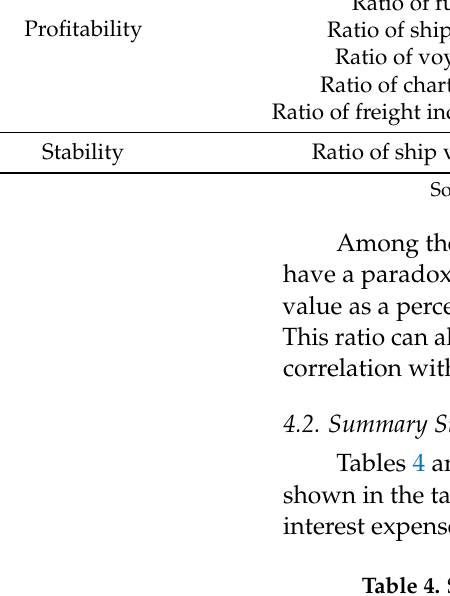
Table 4. Summary statistics of solvent